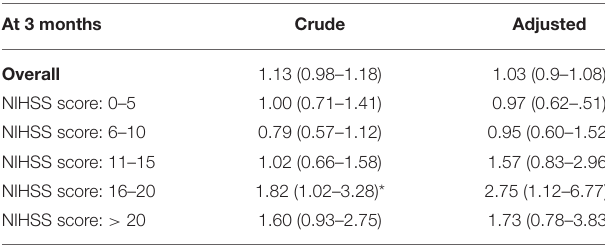
TABLE 3 | Crude and adjusted ORs with 95% CI for the 3-months outcome (mRS 3–5 vs.